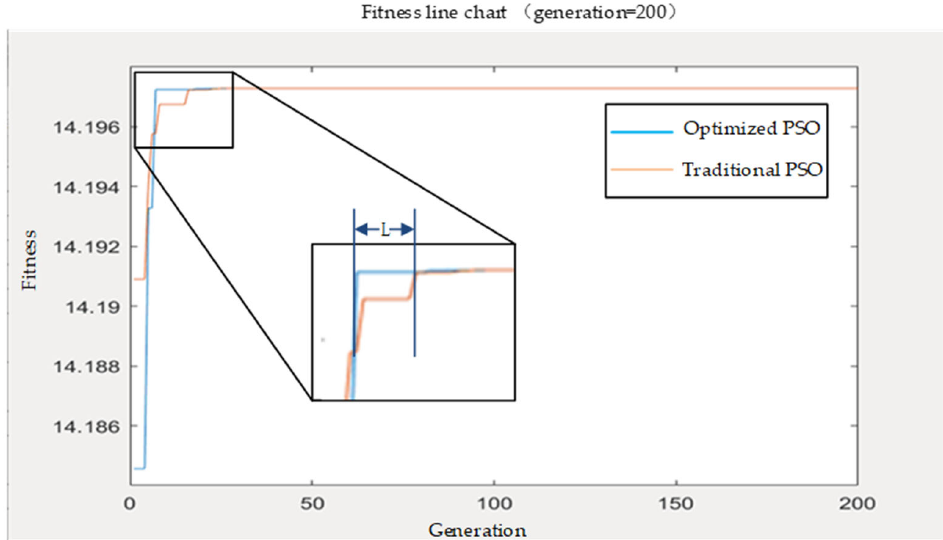
Figure 3. Comparison of optimized processes using MATLAB.